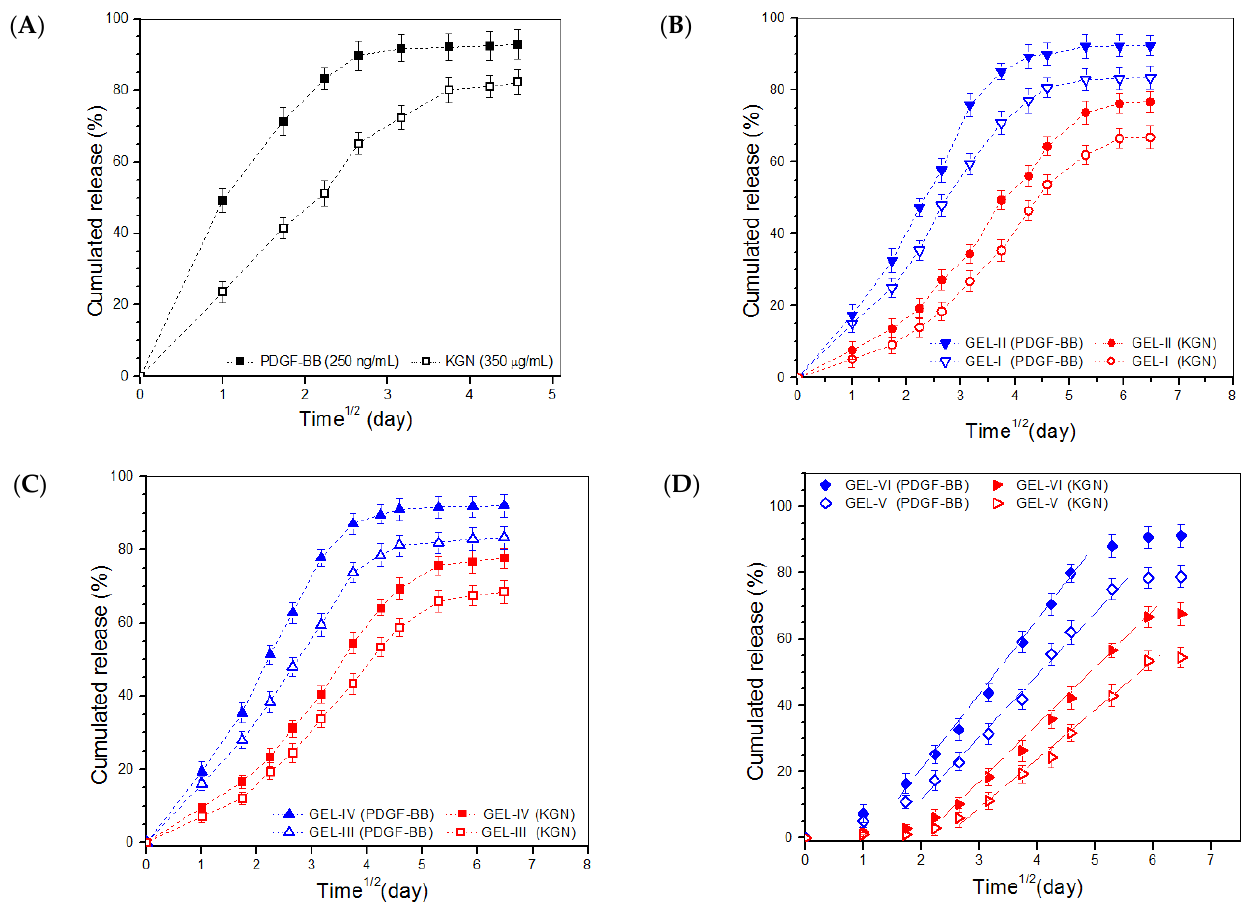
Figure 7. Cumulative release profiles for PDGF/KGN-M MPs ( A ) and composite gels containing varied amounts of PDGF-BB and KGN ( B – D ) (see Tables 1 and 3 for their respective parameters).